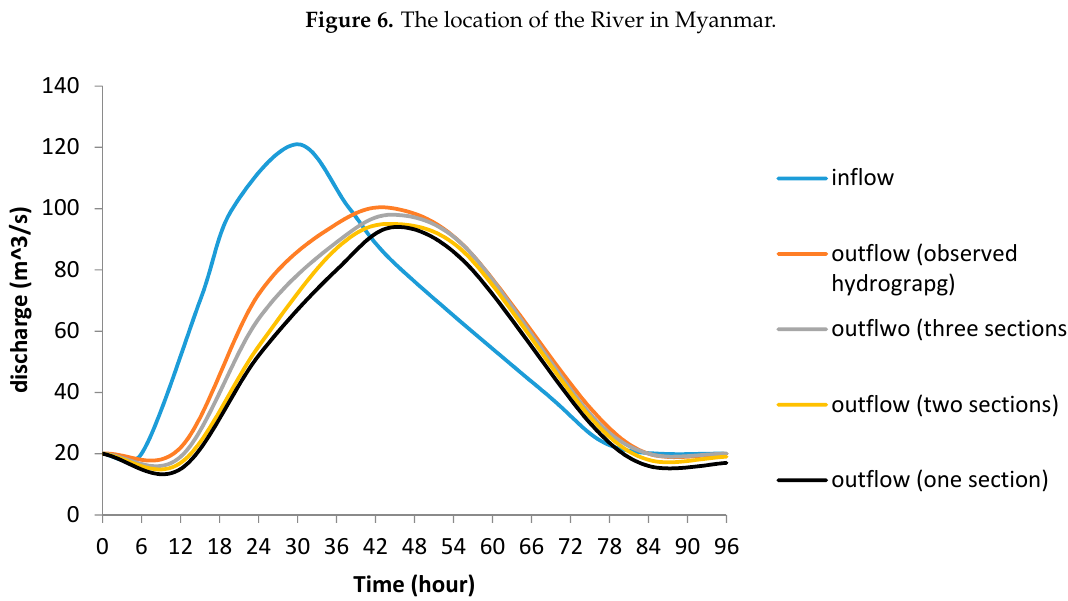
Figure 7. Simulated hydrograph for Myanmar River using IBA.